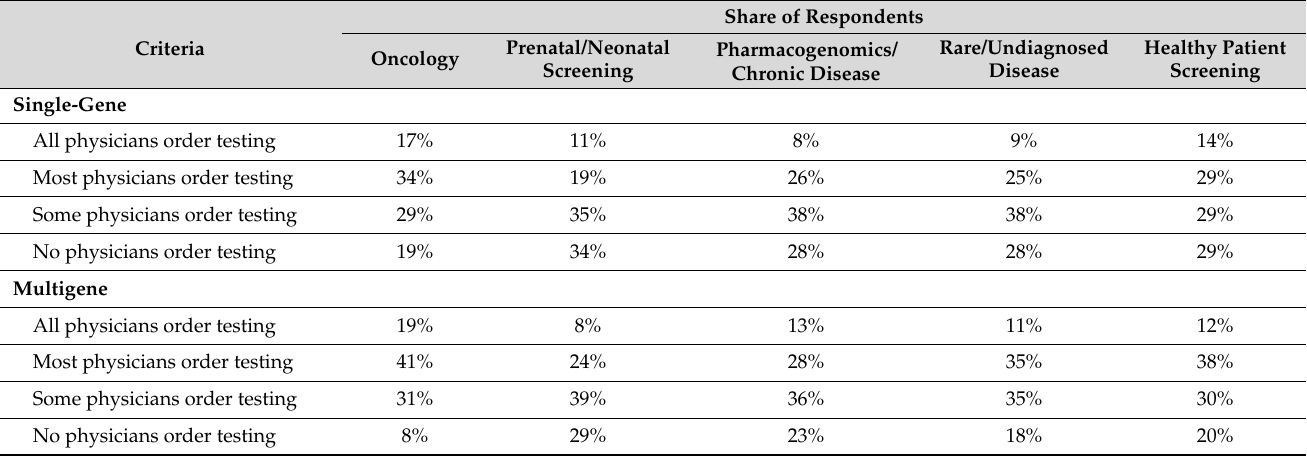
Table 3. Collection of genomic